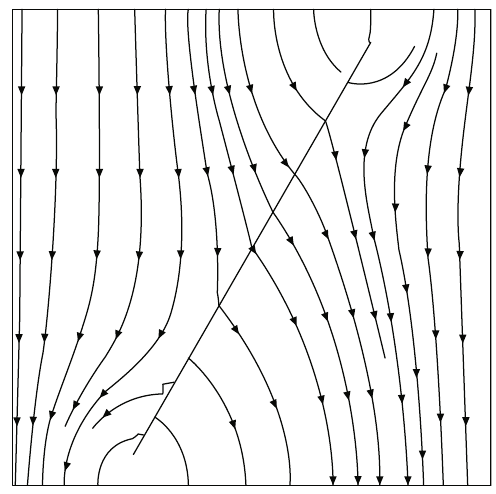
Figure 5: The fl ow vector of the wastewater of the MF model.